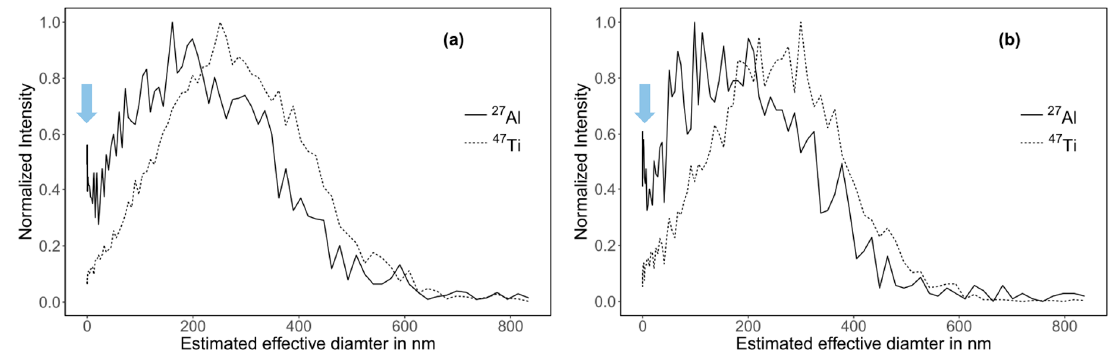
Figure 6. Mass ‐ based PSD of toothpaste particles obtained using HDC ‐ ICP ‐ MS. ( a ) Sample digested Figure 6. Mass-based PSD of toothpaste particles obtained using HDC-ICP-MS. ( a ) Sample digested following method 1 ( b ) Sample digested following method 2. following method 1 ( b ) Sample digested following method